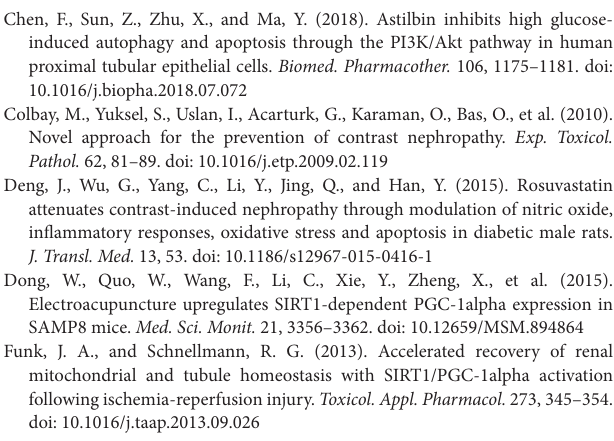
FIGURE S1 | Experimental flow chart for the in vivo model of contrast-induced kidney injury in DN. FIGURE S2 | Positions of typical regions of interest (ROI). (A) T2-weighted image. (B) IVIM parametric images of D (b = 0 s/mm 2 ). CO, renal cortex; OM,